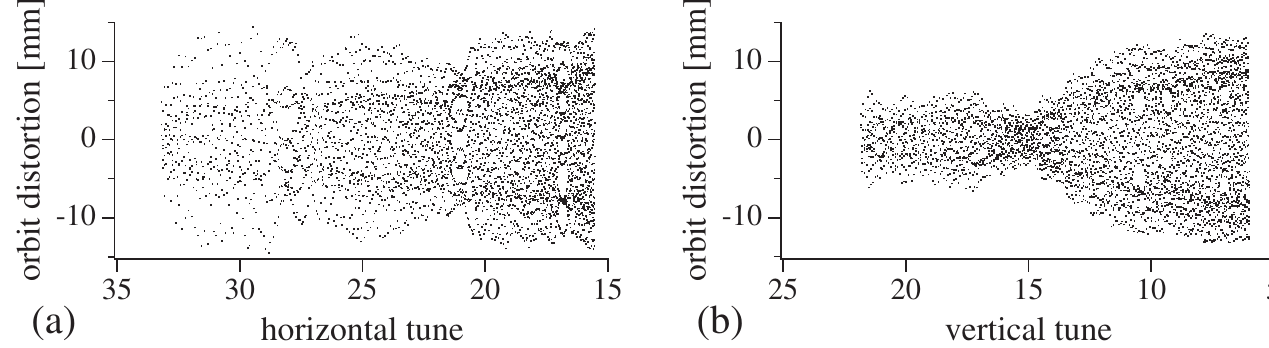
FIG. 5. Evolution of (a) horizontal and (b) vertical orbit distortion when alignment error of 0.10 mm ( 1 (cid:5) ) is included.